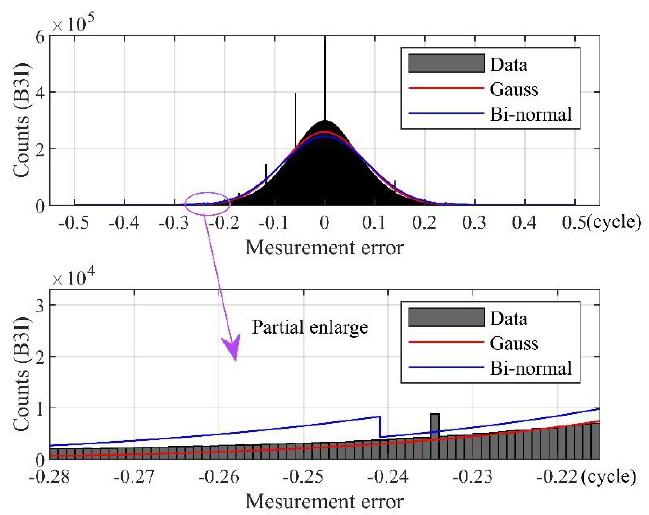
Figure 14. Envelope of bi-normal